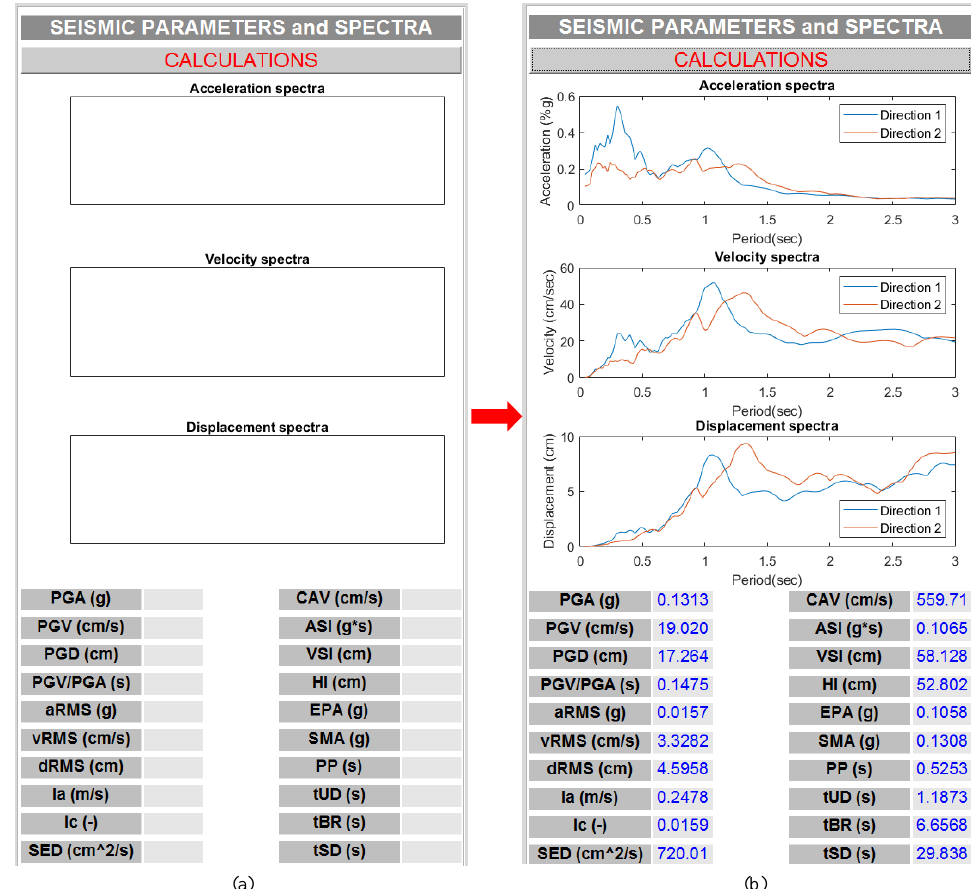
Figure 8. The window used for the presentation of the seismic parameters ( a ) before and ( b ) after running.